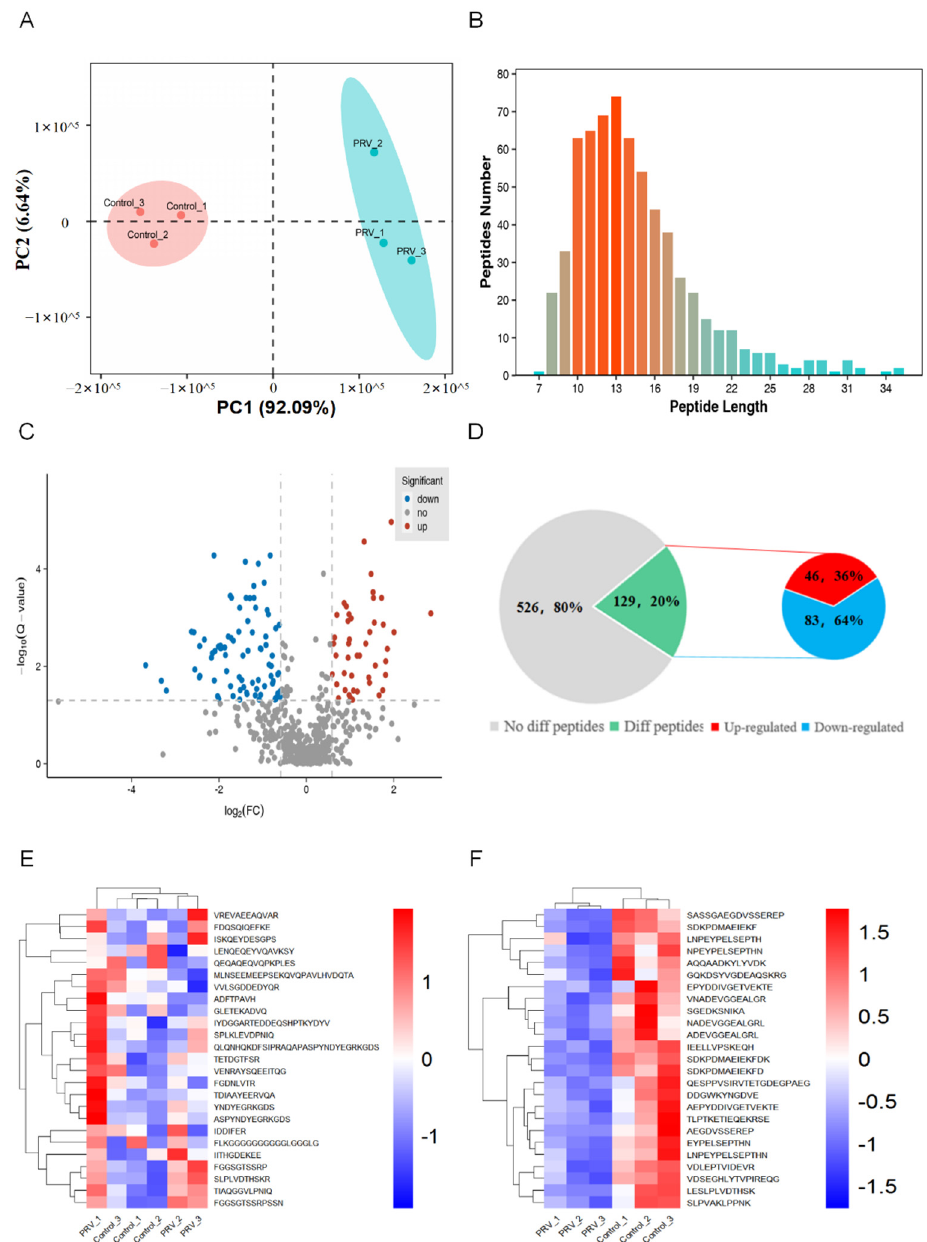
Figure 2. Results of peptidomic data. ( A ) Principal component analysis; ( B ) Map of the distribution of amino acid lengths for all peptides identified by Peptidomic; ( C ) The results of Volcano plot; ( D ) Statistical results of peptidomic; ( E ) Heat map clustering of the top 25 up − regulated peptides; ( F ) Heat map clustering of the top 25 down − regulated peptides.